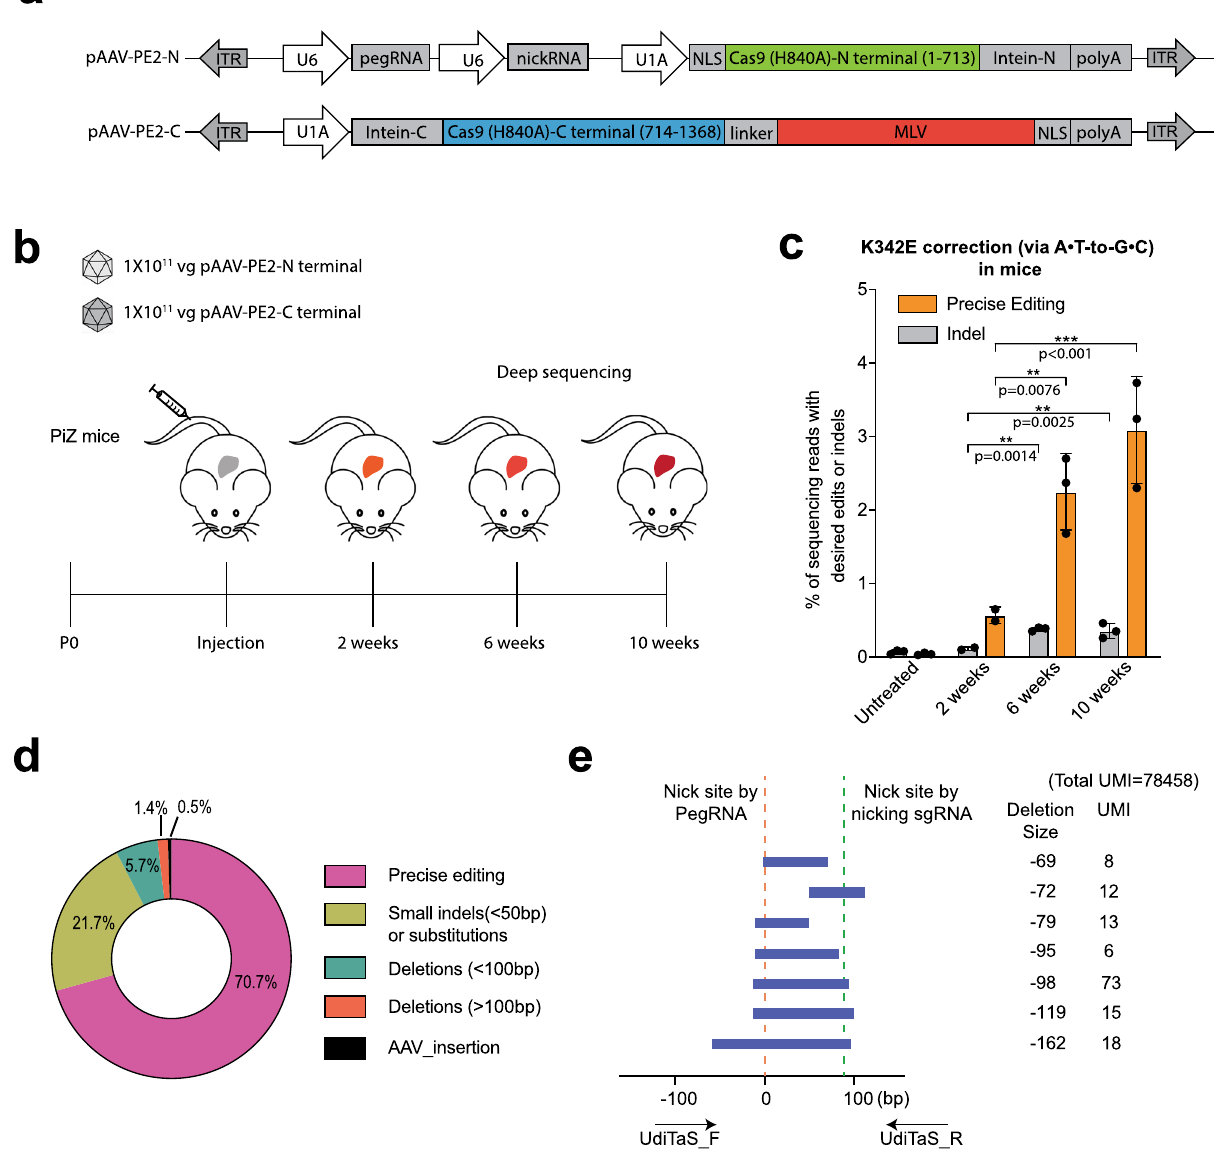
Fig. 5 Systemic injection of dual AAV8 split-intein prime editor achieves pathogenic mutation correction in PiZ mice. a Schematic of split-intein dual AAV prime editor. Full-length primer editor (original PE2 6 ) was reconstituted from two PE2 fragments employing the Npu DNAE split intein 37 . C, carboxy- terminal; N, amino-terminal. b Schematic of the in vivo experiments. Dual AAV8 split-intein prime editor (2 × 10 11 vg total) was delivered to six-week-old PiZ mice by tail-vein injection. Livers were harvested at 2 ( n = 2), 4 ( n = 3), and 10 ( n = 3) weeks after injection and the genomic DNA was isolated for sequencing. c Prime editing ef fi ciency of K342E correction and indels determined by targeted deep sequencing in mouse livers of dual AAV-treated mice. Precise editing is de fi ned as the fraction of sequencing reads with both A to G prime editing and synonymous PAM modi fi cation. Results were obtained from two (2 weeks) or three mice (6 and 10 weeks) and presented as mean ± SD. **P < 0.01, * **P < 0.001 by one-way ANOVA with Tukey ’ s multiple comparisons test. d Composition of edited alleles at SERPINA1 by UDiTaS analysis. The circle plot shows the fraction of edits that are precise (intended base conversion), small indels (<50 bp) or substitution, deletions between pegRNA and nicking sgRNA sites (<100 bp), large deletions (>100 bp), and AAV fragment insertion. Numbers are average of 3 mice in 10 weeks treated cohort. e The statistically signi fi cant large deletion sequences detected by UDiTaS in the 10 weeks treated cohort are displayed as bars spanning the sequence that is deleted (a representative liver of n = 3 mice). Positions of the pegRNA and nicking sgRNA are indicated by dotted lines and the approximate positions of the locus-speci fi c UDiTaS primers are indicated by arrows below the bar chart. The deletion size and number of UMIs associated with each deletion are indicated to the right of each bar. Statistical signi fi cance was calculated as a Benjamini – Hochberg adjusted p -value with a cut-off of